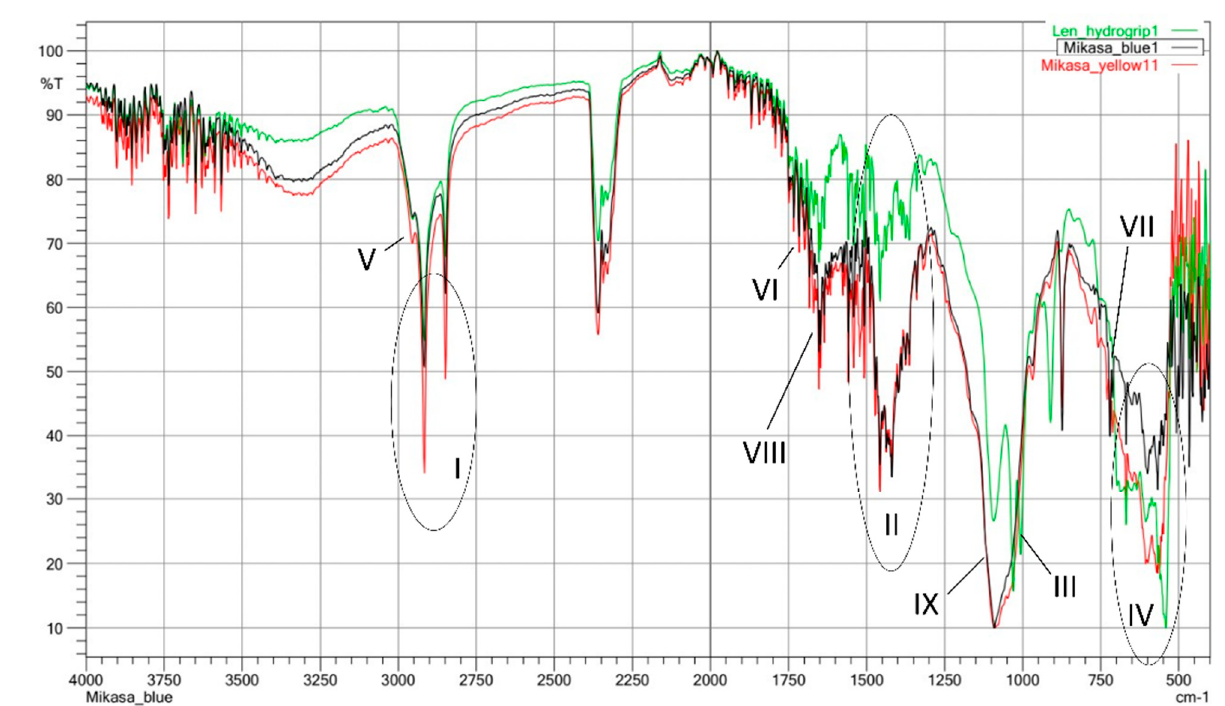
Figure 8. FTIR spectra of sample Kap 7 (green line), Mikasa (red and black line). The characteristic signals: I—range of 2945 to 2830 cm − 1 ; II—range of 1495 to 1293 cm − 1 ; III range 1147 to 975 cm − 1 ; IV—range of 760 to 525 cm − 1 ; V—wave-length of 2985 cm − 1 , VI—range of 1748 to 1640 cm − 1